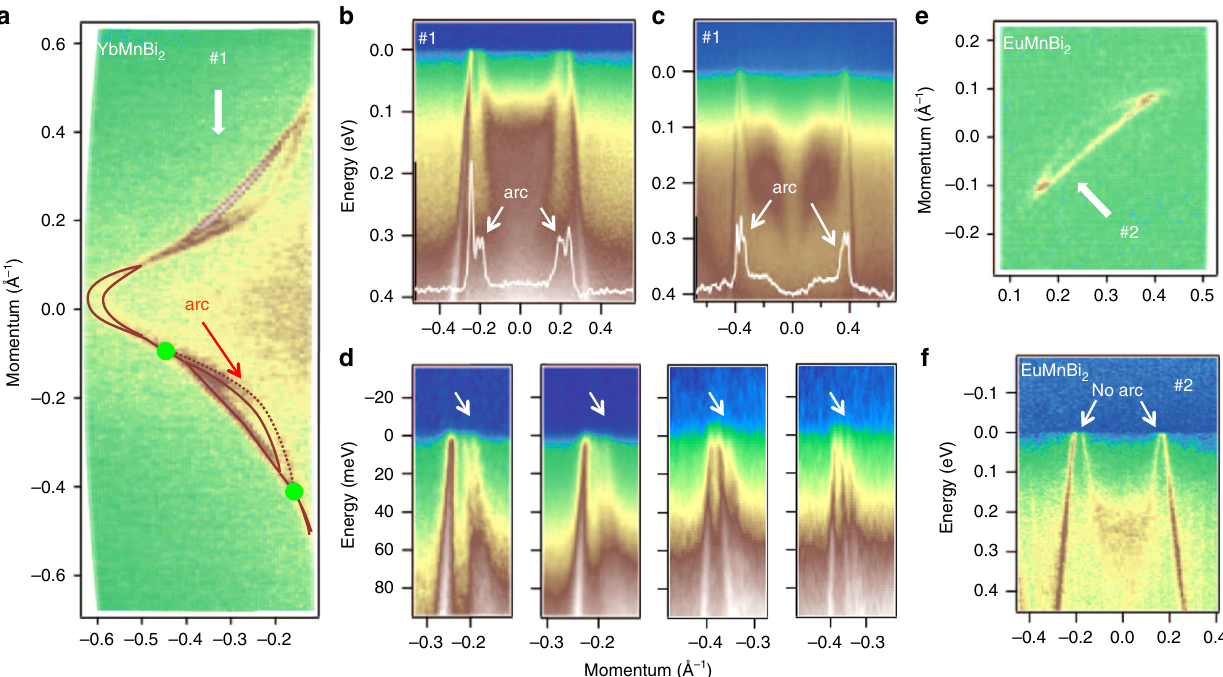
Fig. 3 Fermi surface arc. a High-precision Fermi surface map of YbMnBi 2 at h ν = 20.5 eV showing unusual number of features (brown lines) which can be explained by the presence of the arc (dotted line) corresponding to the surface states connecting the Weyl points (green points). b Spectra corresponding to cut #1 shown in panel ( a ) by white arrow ( h ν = 20.5 eV). White curve is the momentum-distribution curve at the Fermi level showing the presence of six crossings. The inner ones are due to the arc. c Same as in ( b ) but for h ν = 27 eV. d Zoomed in fragments of panels ( b ) and ( c ) as well as similar data for other photon energies. e High-precision Fermi surface map of EuMnBi 2 . f Spectra along the cut #2 indicated by white arrow in ( e ). Photon energy is 27 eV. No sign of the arc is present in the